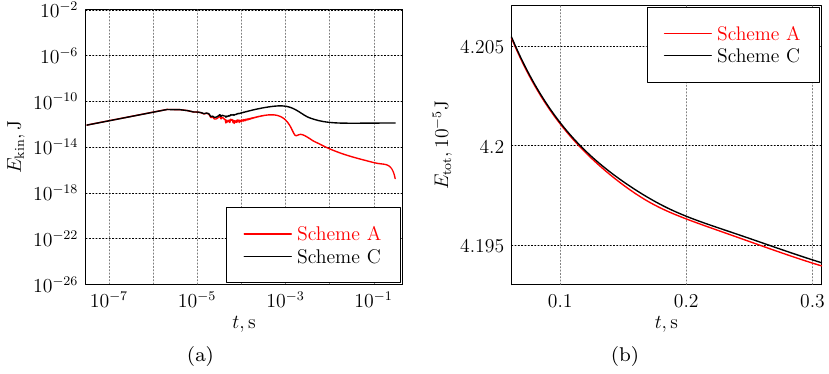
Figure 6. Problem 3.1: plots of E kin ( t ) (a) and E tot ( t ) (b) for schemes A and C in the